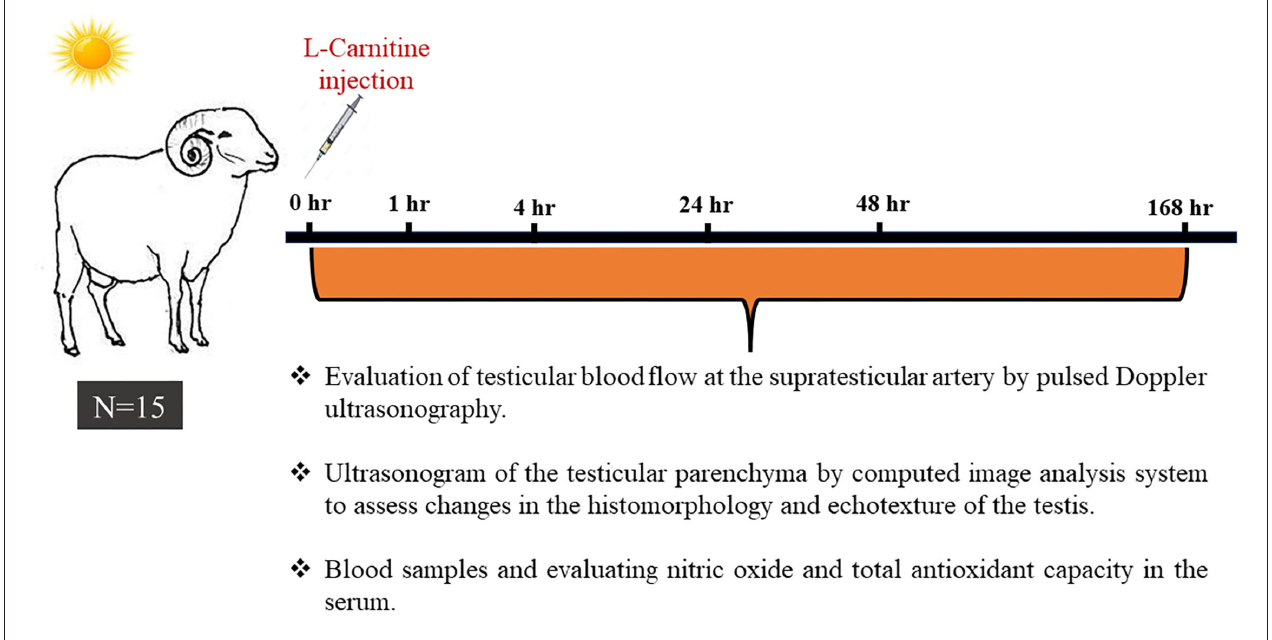
FIGURE 1 | A schematic diagram shows the experimental design, in which fifteen Ossimi rams exposed to environmental heat stress (temperature-humidity index = 32.5) were administered L-carnitine (LC; 20 mg/kg BW; IV) and underwent ultrasound examination and blood sampling just before L-carnitine administration (0h) and 1, 4, 24, 48, and 168h post-LC